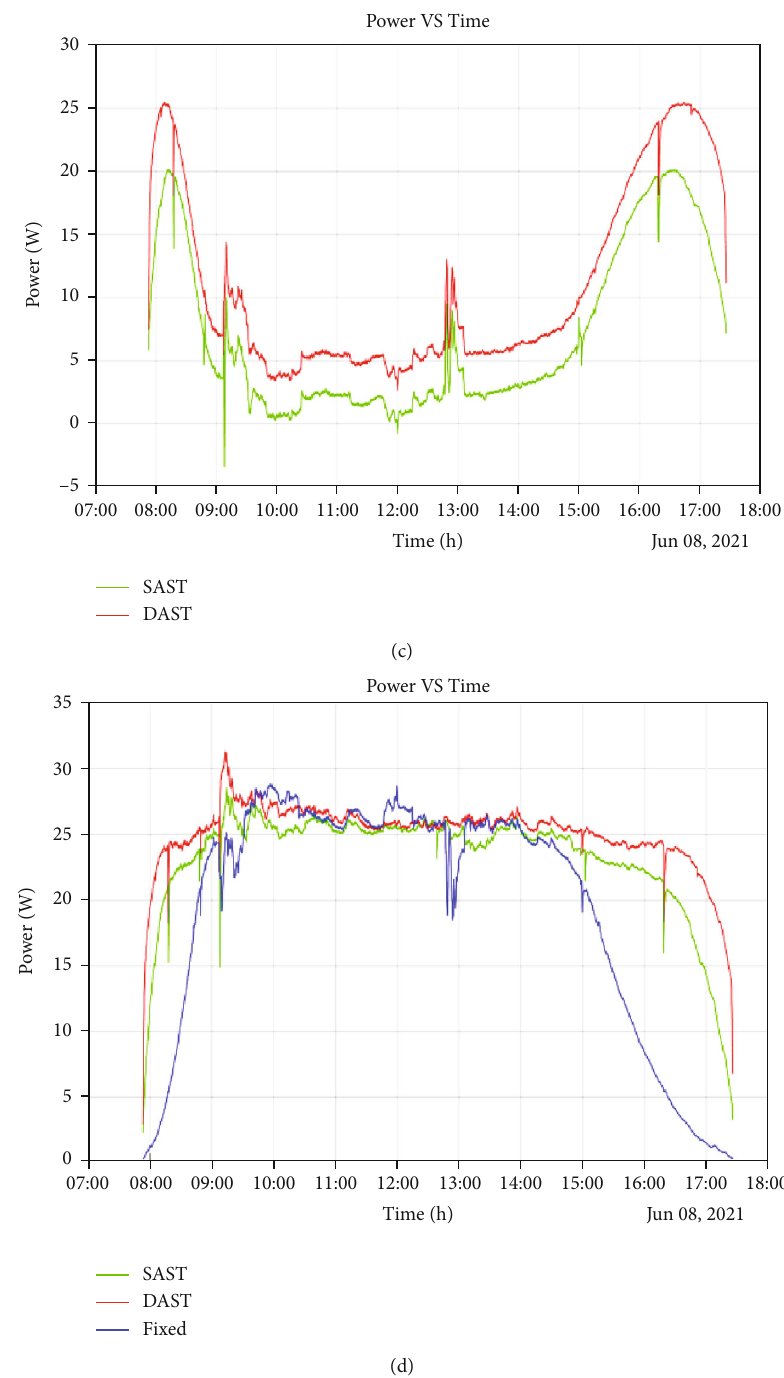
Figure 12: (a) Power generation, consumption, and the net power of SAST. (b) Power generation, consumption, and net power of DAST. (c) Increase in power (power improvement) of SAST and DAST. (d) Net power of SAST, DAST, and